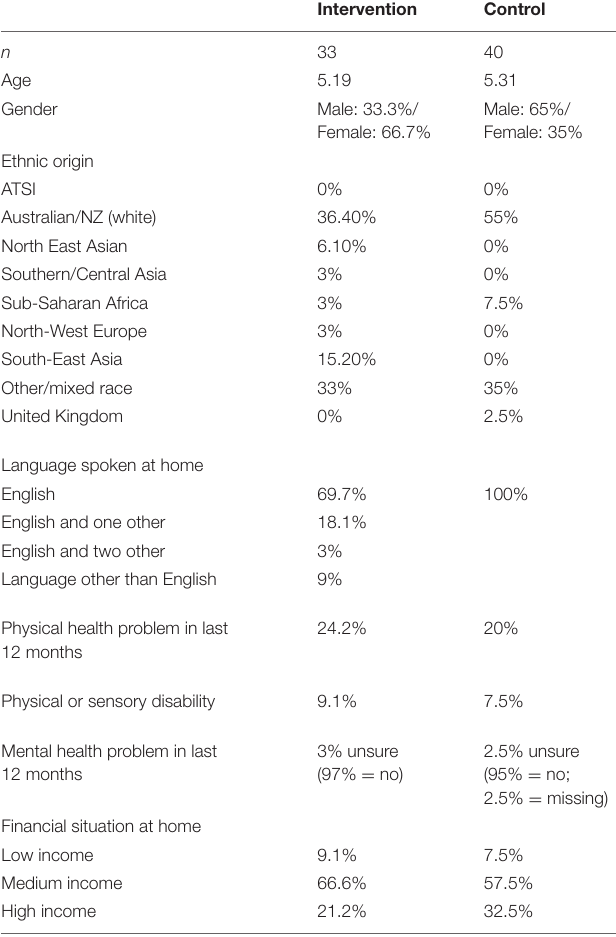
TABLE 1 | Participant demographic information.